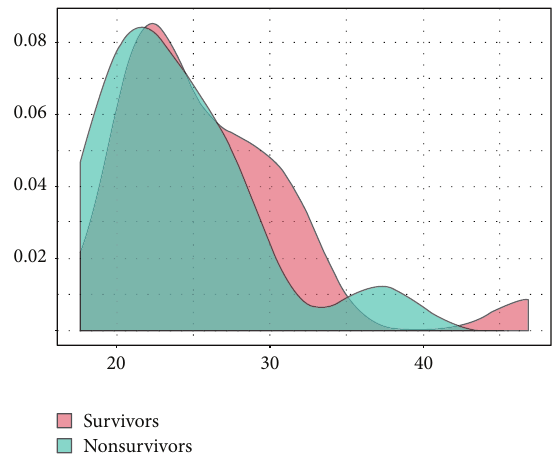
Figure 1: Density plot for BMI in survivors and nonsurvivors. There was no difference between groups ( 𝑃 =